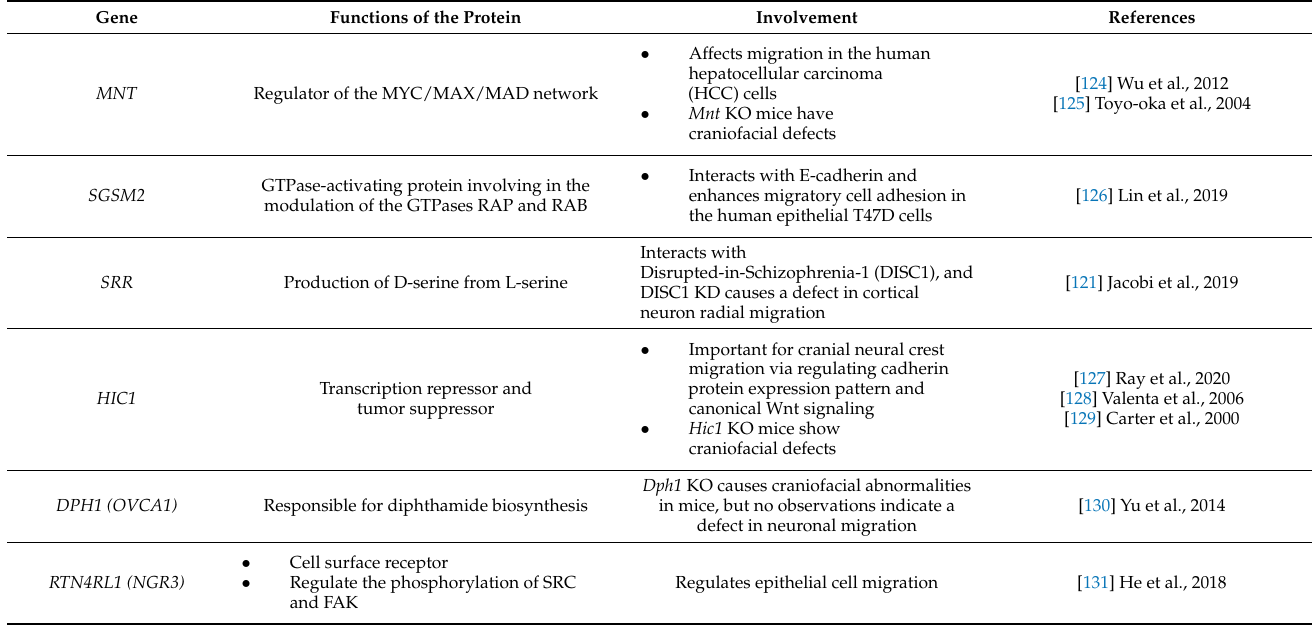
Table 1. Genes’ functions and involvements in cell